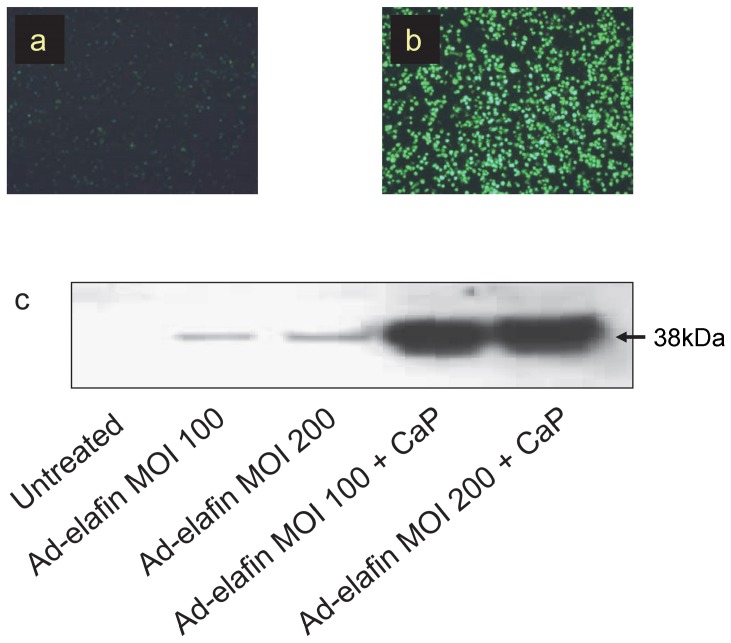
Incorporation of adenovirus into calcium phosphate precipitate increases the infection efficiency of alveolar macrophages in vitro.Ovine alveolar macrophages were cultured at a density of 250,000 per well in 48 well plates and were infected with Ad-GFP and Ad-o-elafin-FLAG at MOI 100 or 200 either pre-complexed with calcium phosphate or as virus alone. (a) – Ovine alveolar macrophages 24 hours after infection with Ad-GFP MOI 100 alone. (b) – Ovine alveolar macrophages 24 hours after infection withAd-GFP MOI 100/calcium phosphate co-precipitate. (c) – Western blot analysis of ovine alveolar macrophage supernatant using Trab-2O antibody 4 days after infection with Ad-o-elafin-FLAG at MOI 100 and 200 either with or without coprecipitation with calcium phosphate. Uninfected alveolar macrophage supernatant is included as a control.